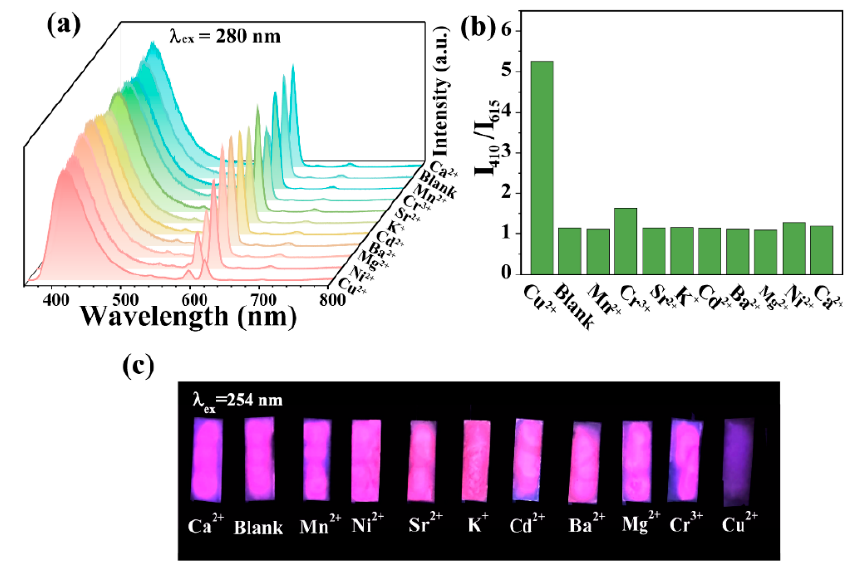
Figure 3. Specific identification performance of CDs-F2 ( a ) and detailed drawing of the selectivity ( b ). ( c ) The photographs of CDs-F2 silica plate containing various metal ions solution under 254 nm UV light irradiation.